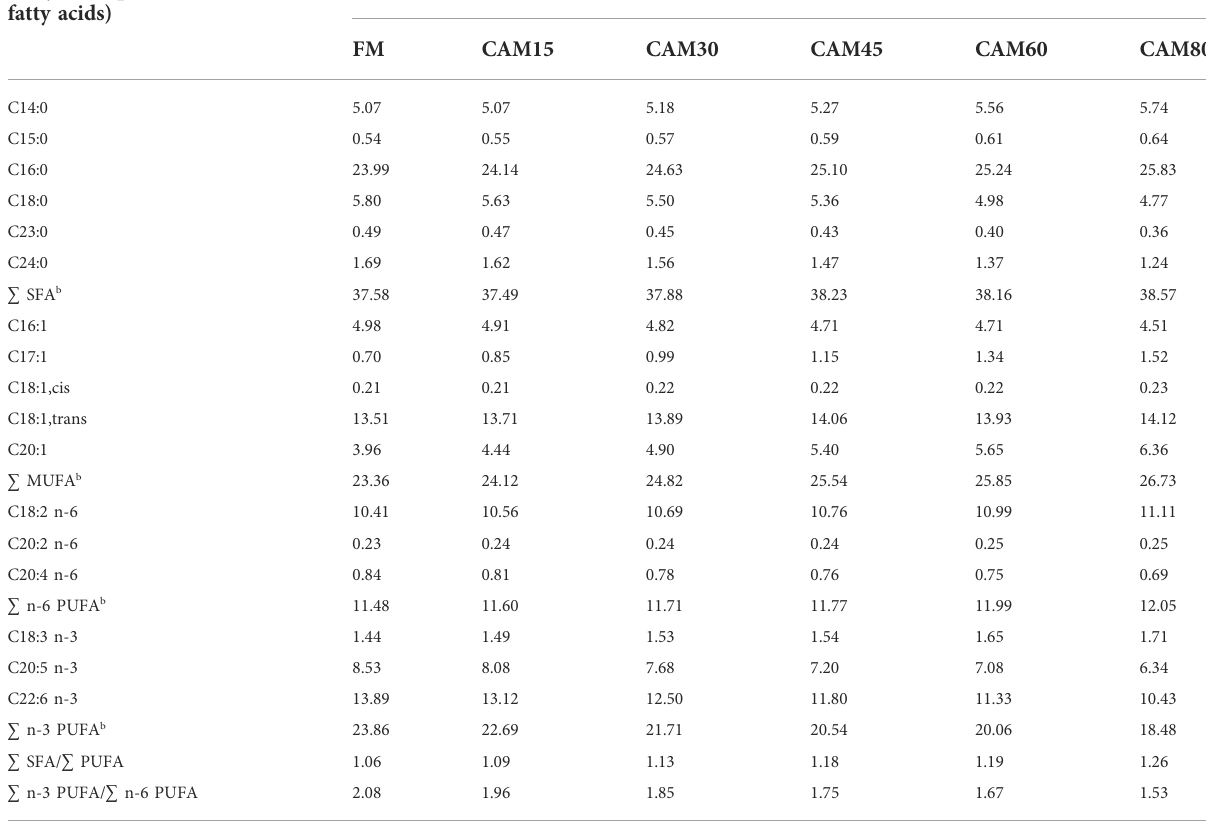
TABLE 2 Fatty acids pro fi le of experimental diets (% total fatty acids). Fatty acids pro fi le/(% total fatty